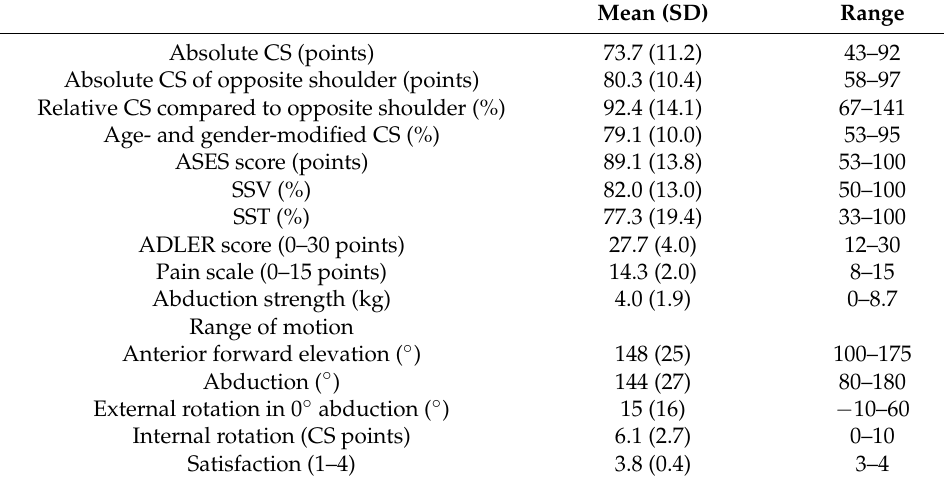
Table 2. Final postoperative clinical scores and range of